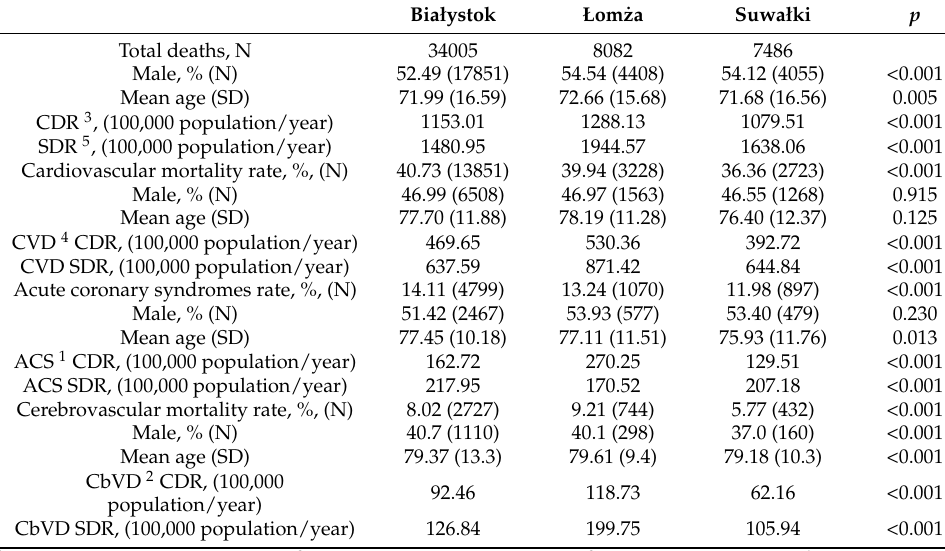
Table 1. Mortality in the studied region in the years 2008–2017. Białystok Łom˙za